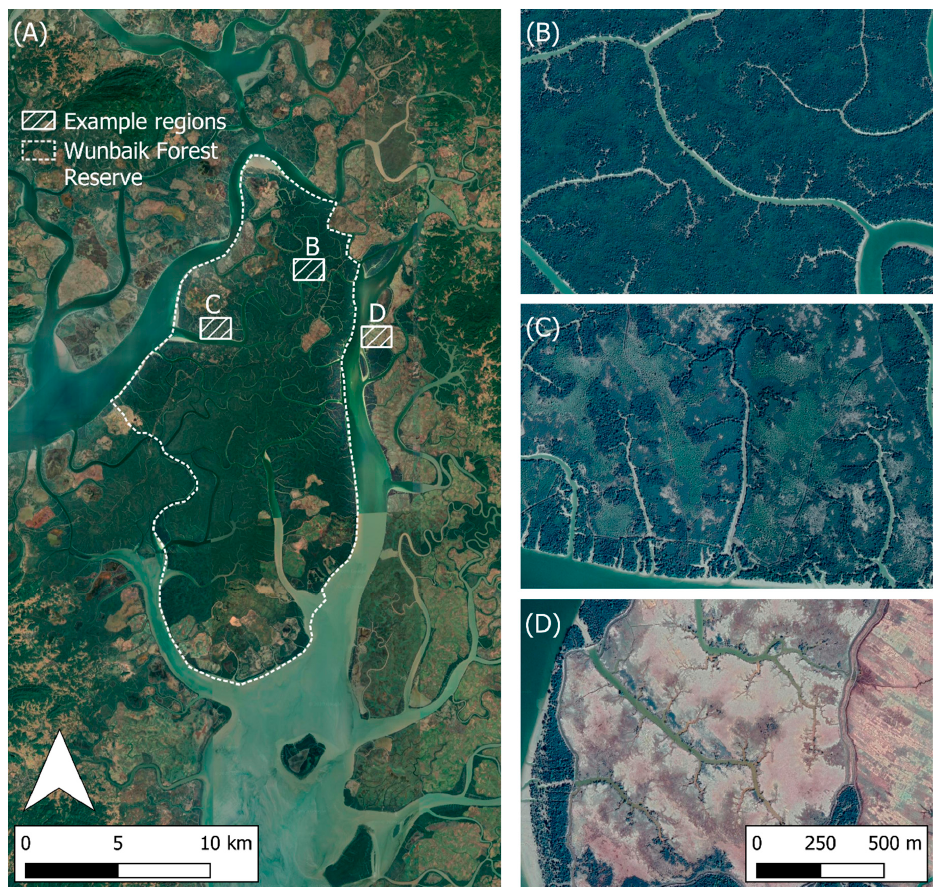
Figure 3. Examples of mangrove ecosystem degradation in Rakhine, Myanmar. ( A ) High resolution imagery from Google Earth (2018) of mangroves in the region around the Wunbaik Forest Reserve, Rakhine. Zoomed in images represent examples for ( B ) intact, ( C ) degraded, and ( D ) collapsed classes. Image data provided by Landsat/Copernicus, CNES/Airbus, Google, and Maxar Technologies.